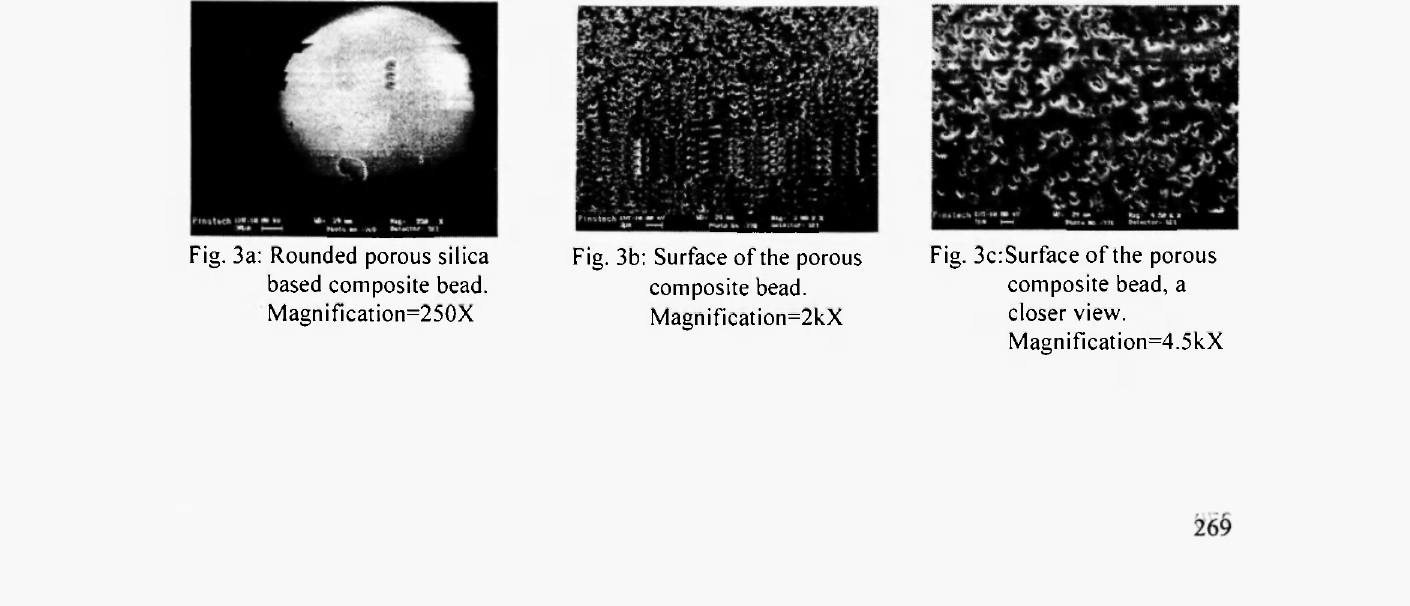
Fig. 3a: Rounded porous silica based composite bead. Magnification=250X